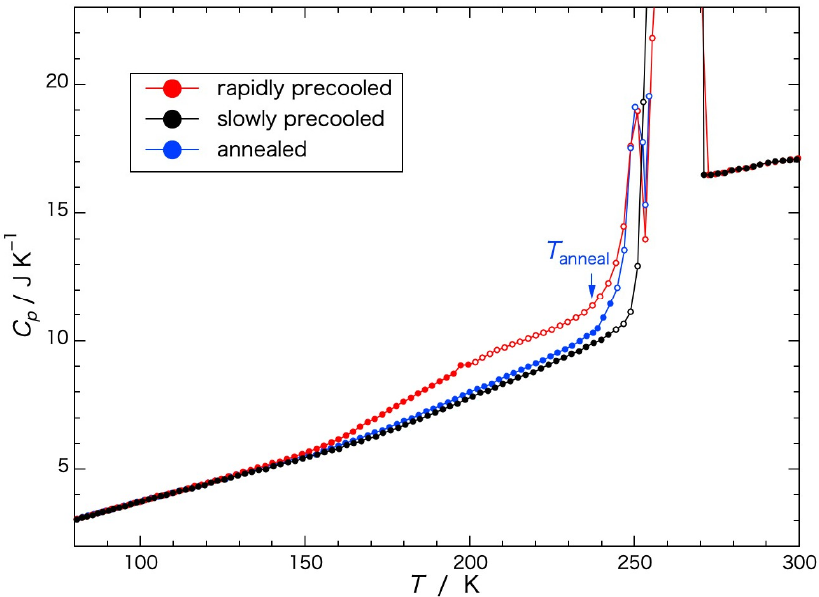
Figure 2. Heat capacities of a Sephadex ® G25 gel ( h = 1.00) dependent on the rate of previous cooling. ● : rapidly precooled, ● : slowly precooled, ● : annealed. Open circles represent the data obtained before reaching equilibrium. T anneal indicates a temperature of annealing.